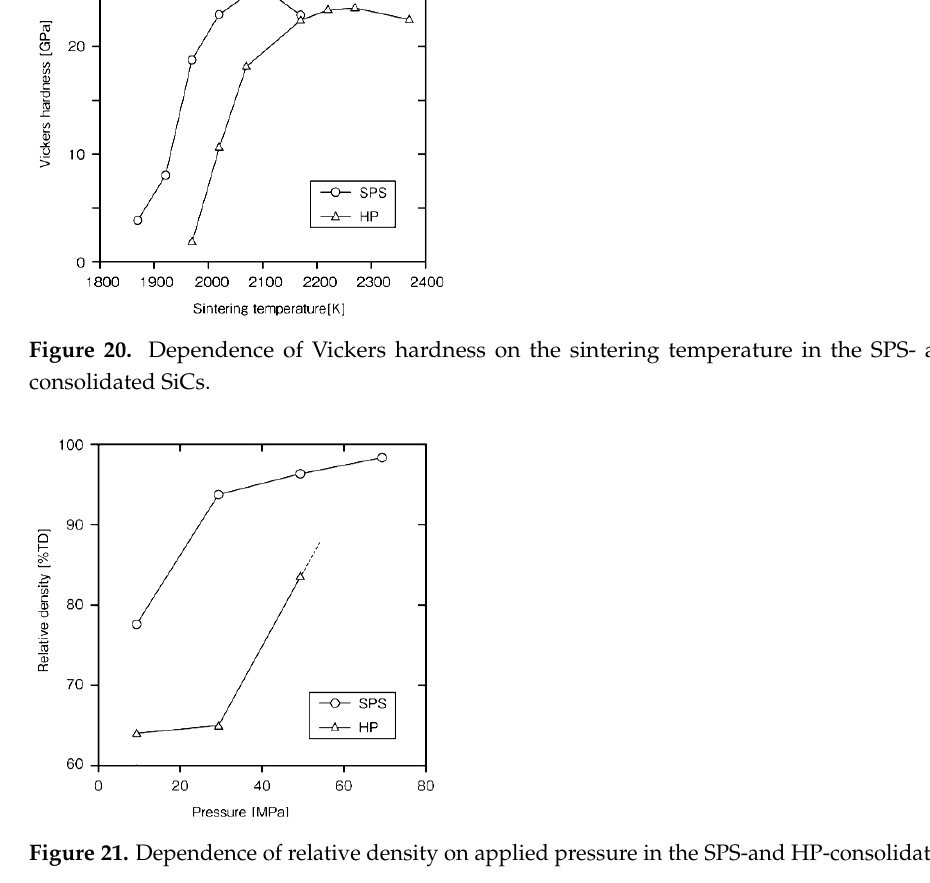
Figure 23. SEM photos of etched surfaces: ( a ) SPS-consolidated SiC (2073 K, 30 MPa); ( b ) HP-consolidated SiC (2273 K, 30 MPa).